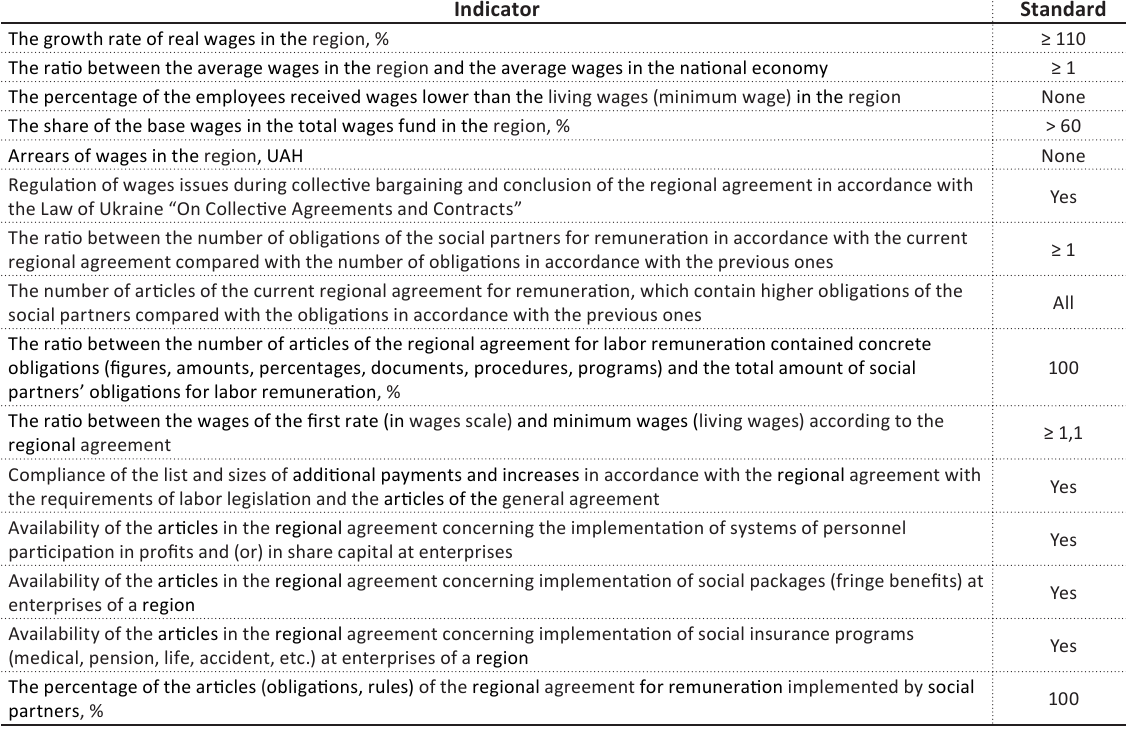
Table 1. Indicators for assessing the remuneration policy in terms of decent work at the regional level